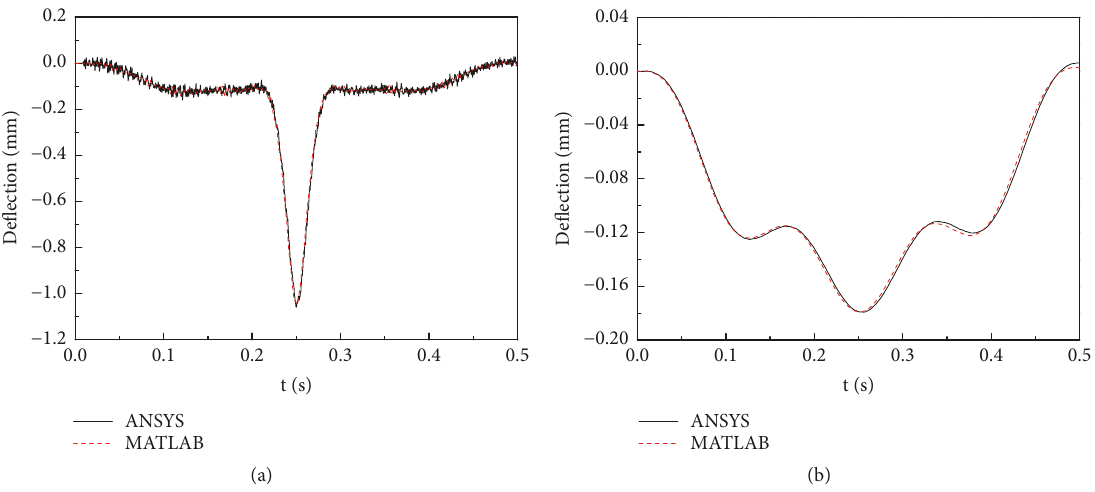
Figure 4: Mid-span deflection time-history for double simply supported rail-bridge system with load moving speed v = 64 m/s: (a) first beam; (b) second